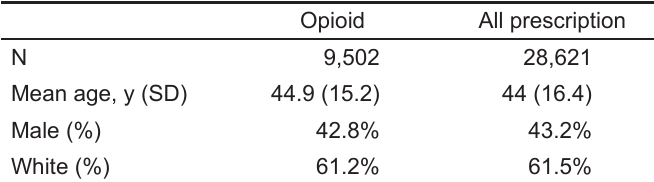
Table 2. Demographics of patients receiving opioid versus non- opioid prescriptions.